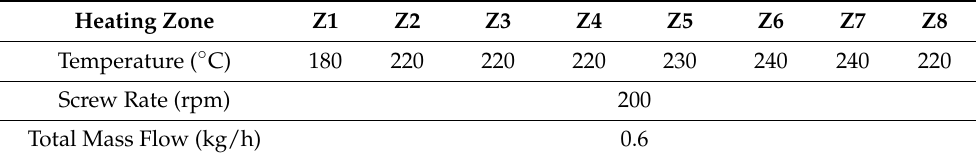
Figure 1. Schematic illustration of the extruder zones. Table 1. Extrusion conditions for production of the filaments.